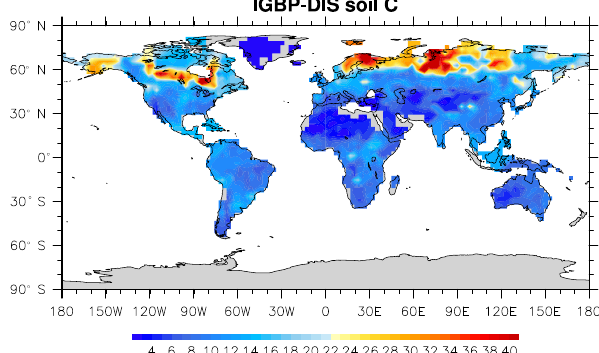
Figure 2. IBGP-DIS soil carbon distribution. Soil carbon varies from 0kgm − 2 in deserts to 60kgm − 2 in boreal